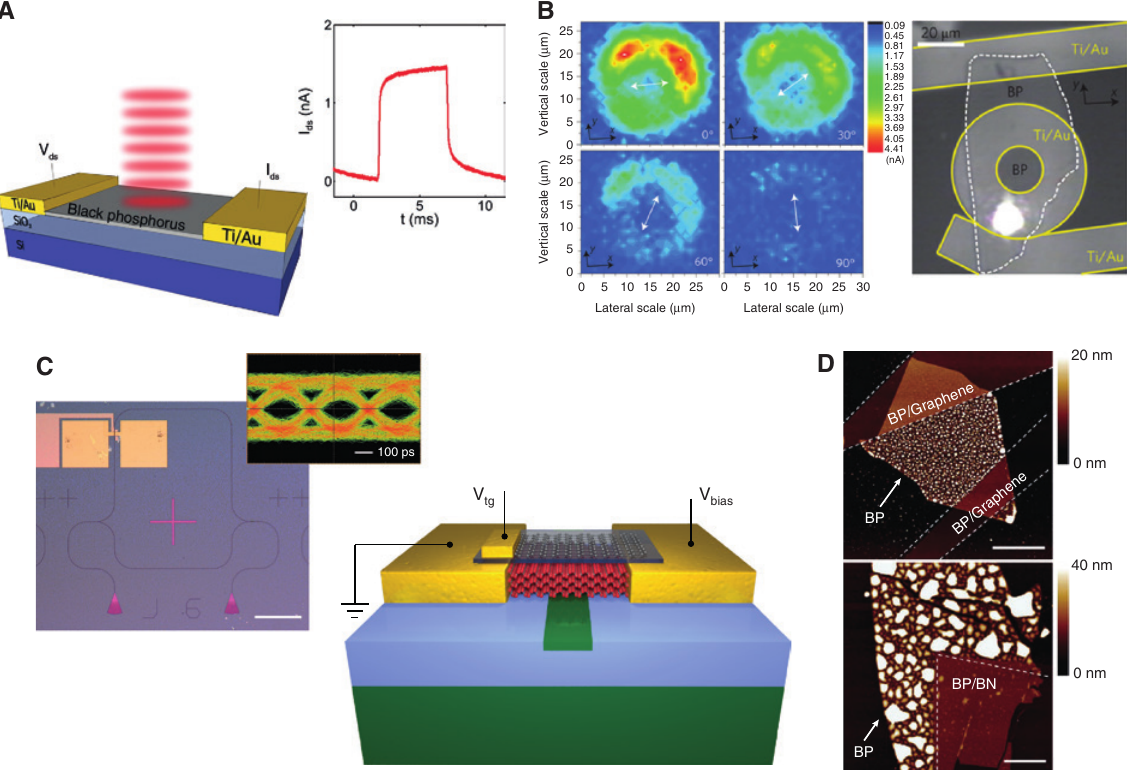
Figure 3: Black phosphorus photodetectors. (A) Normal incidence black phosphorus photodetector. Slow detection speeds were observed in this device with a rise and fall time on the order of a few milliseconds. (B) Polarization-dependent photocurrent in BP. Anisotropic optical absorption along the x- vs. y-direction accounts for the difference in measured photocurrent. (C) BP waveguide-integrated photodetector. A top gate is used to dope the channel intrinsic for high-speed detection. The device shows an open eye diagram for data rates as high as 3 Gbps. (Scale bar for optical image is 100 μ m.) (D) Methods for passivating BP using van der Waals heterostructures. Both graphene and BN provide high-quality passivation as can be seen in AFM profiles of partially covered BP allowed to oxidize (scale bars are 4 μ m). Reproduced with permission from Refs. [50] (A), [51] (B), [41] (C), and [52]